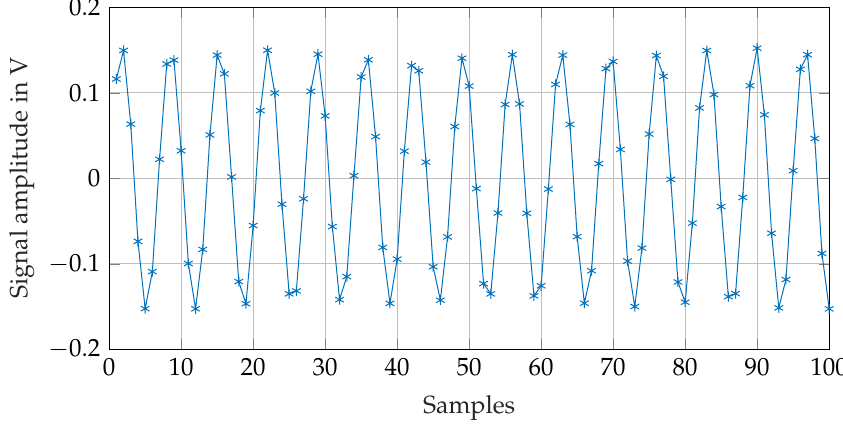
Figure 15. Receiver signal: first 100 samples of the marked region in Figure 14.